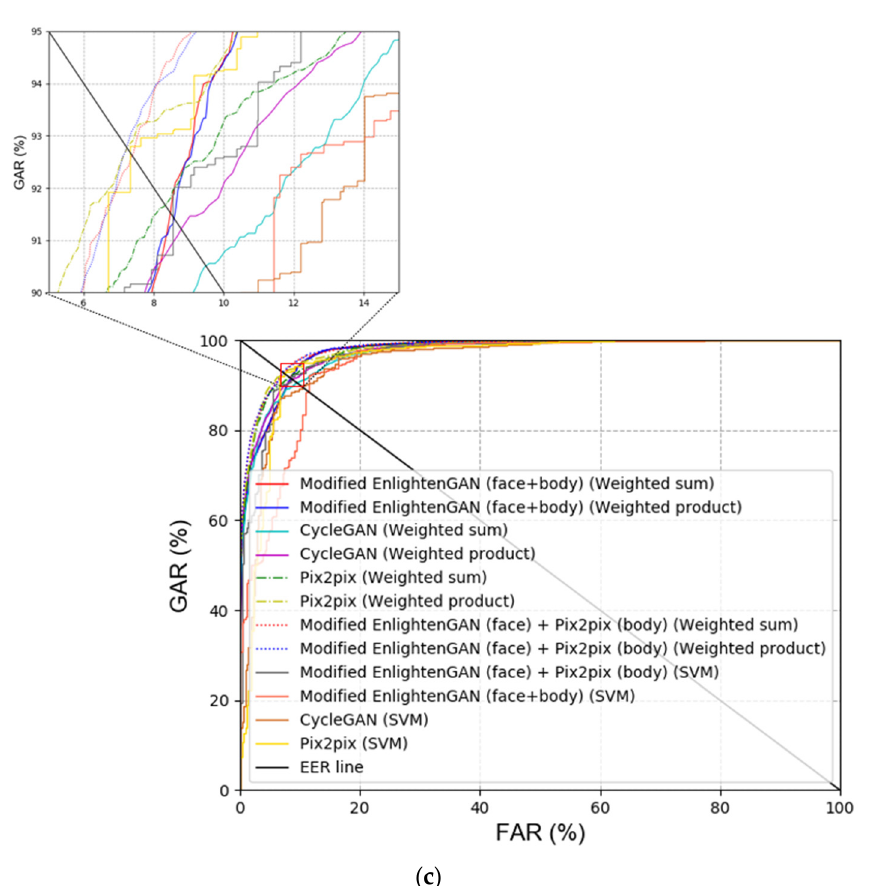
Figure 9. Graph for ROC curves acquired using our method and the previous GAN-based techniques. ( a , b ) Recognition results for face and body images, and ( c ) score-level fusion result.